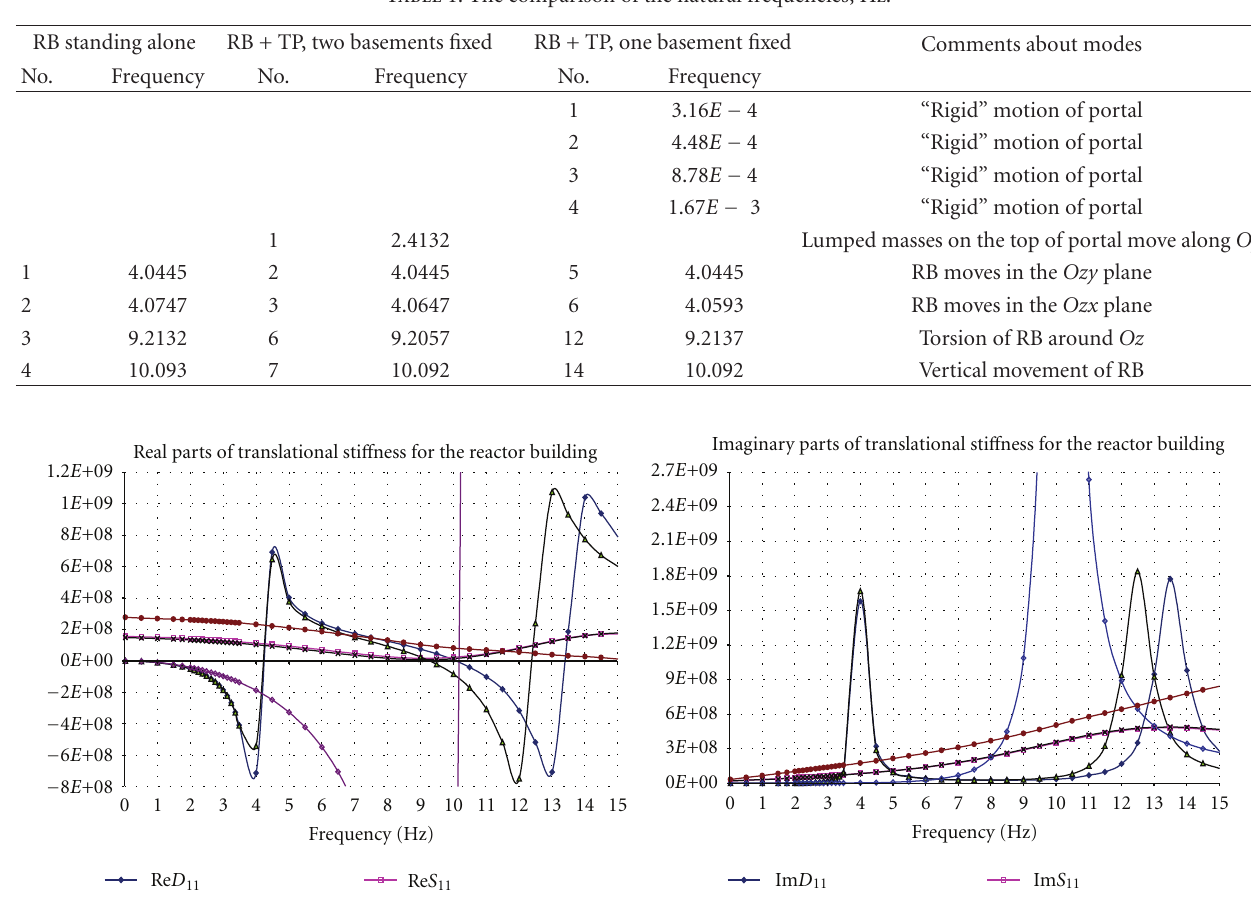
Table 1: The comparison of the natural frequencies, Hz.